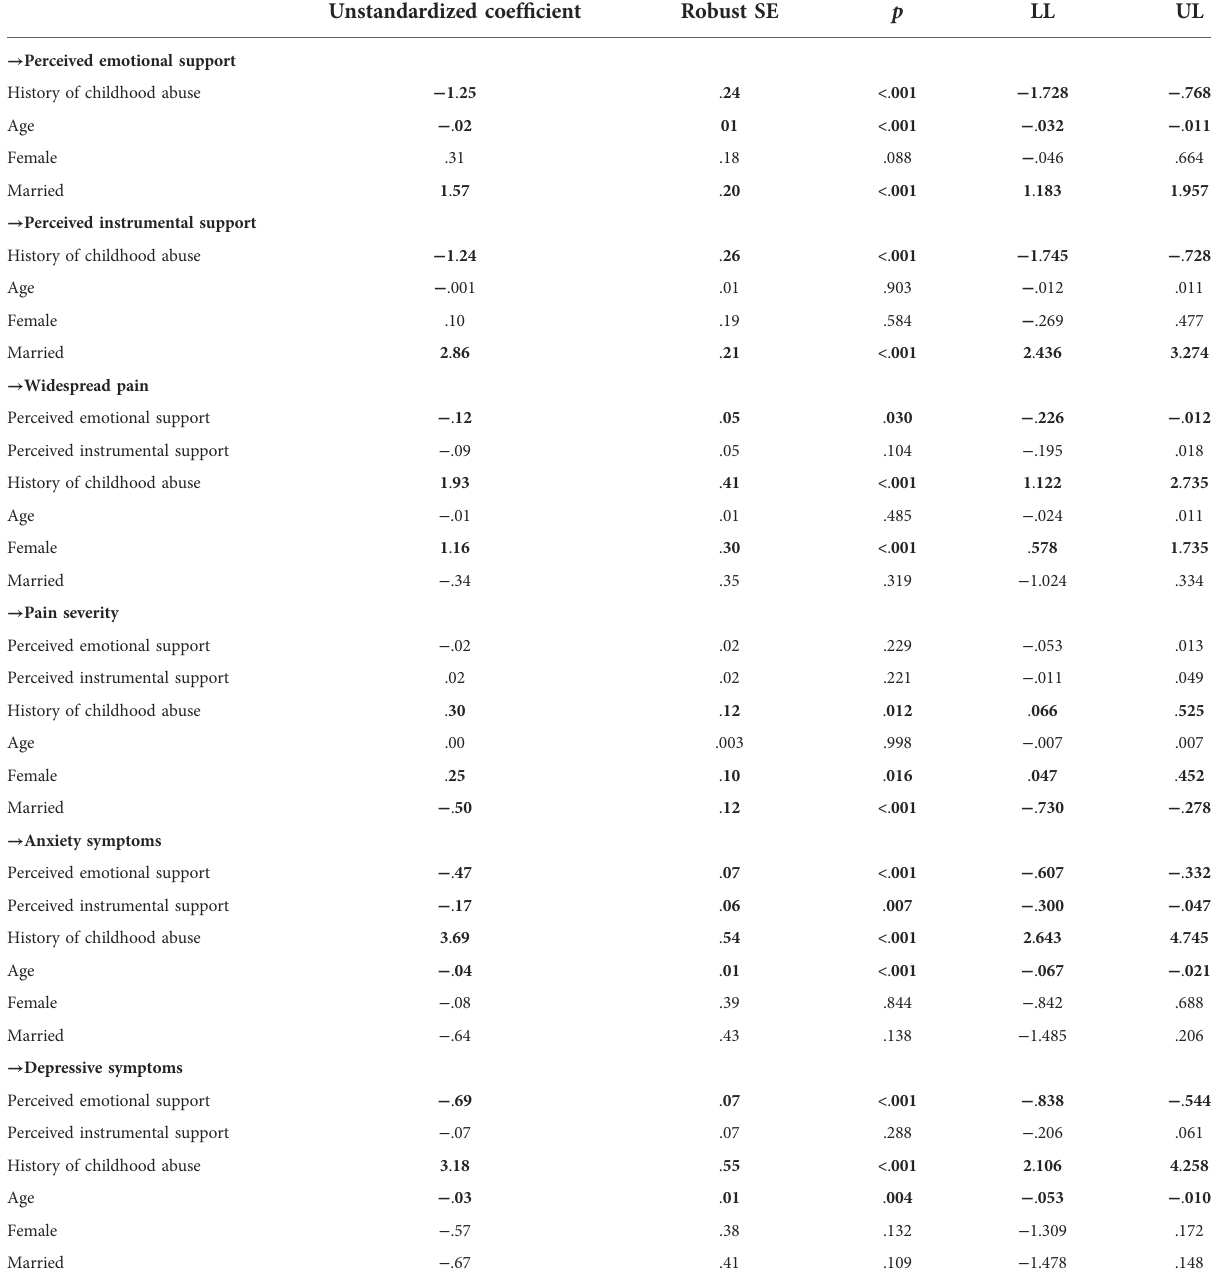
TABLE 2 Unstandardized coef fi cients, robust SEs, and 95% CIs for fi nal mediation model of the association between history of childhood abuse and pain-related characteristics ( n